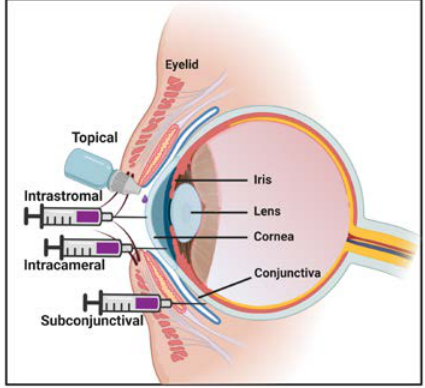
Figure 3. Injection routes for corneal gene therapy. Reported routes for gene therapy targeting the cornea have included direct intrastromal injection, intracameral injection, topical application (incubation after epithelial removal), and subconjunctival injection. Table 2. Cornea route of administration and transduced cells/section.